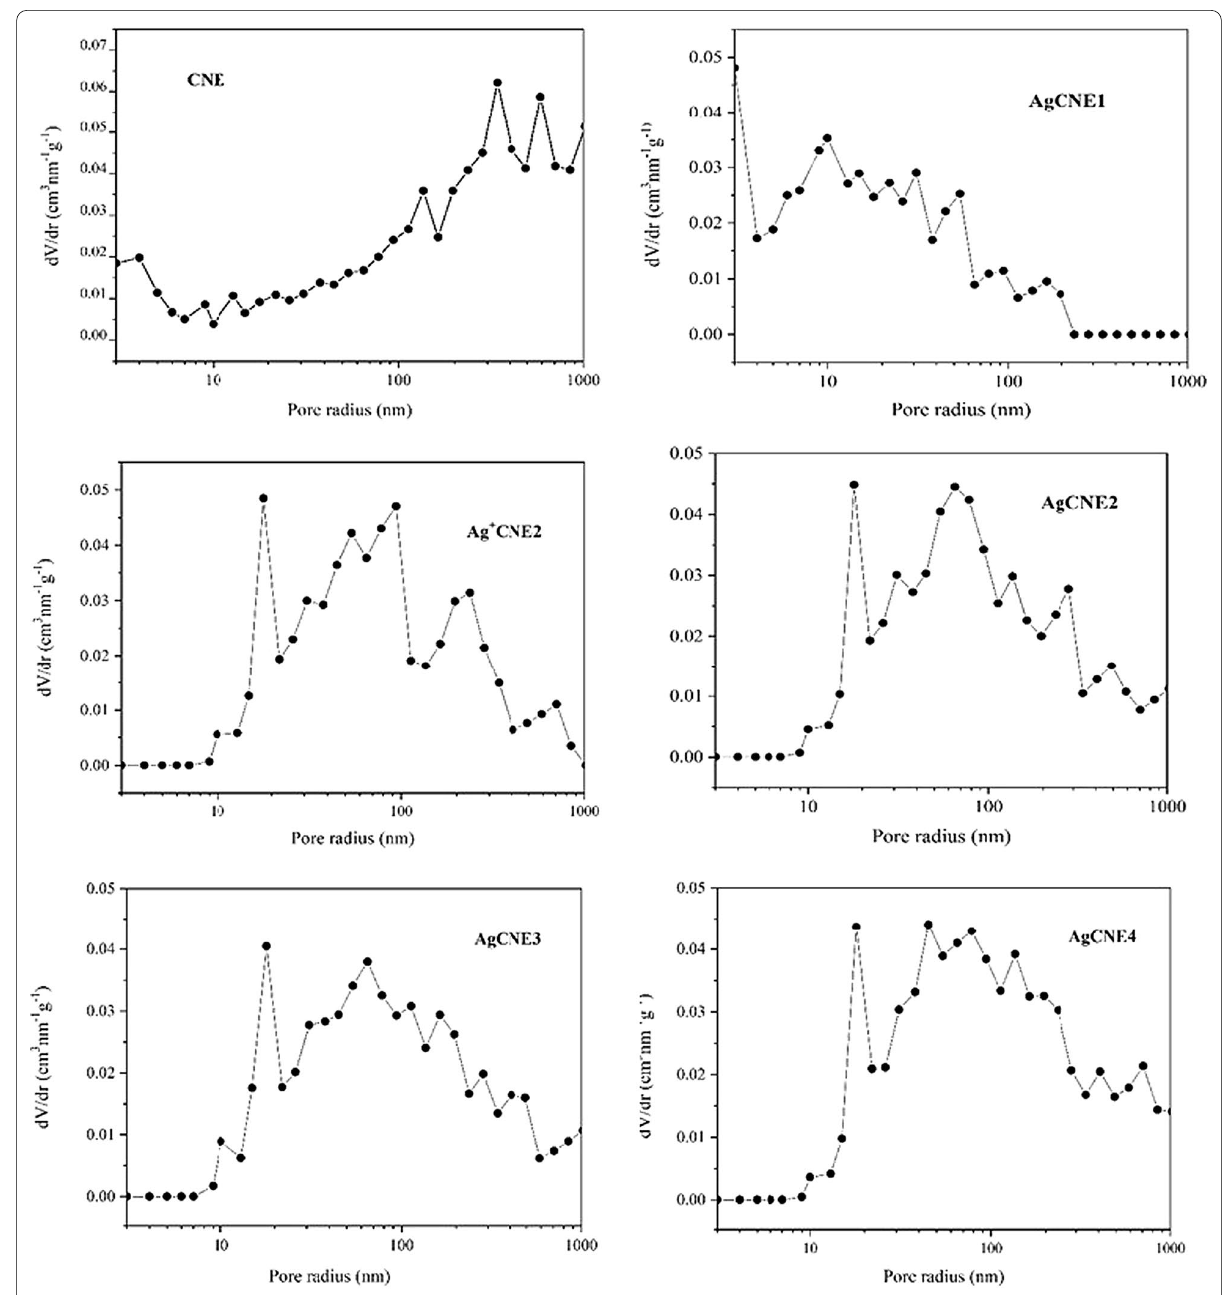
Fig. 9 BJH pore size distribution curves of AgCNE